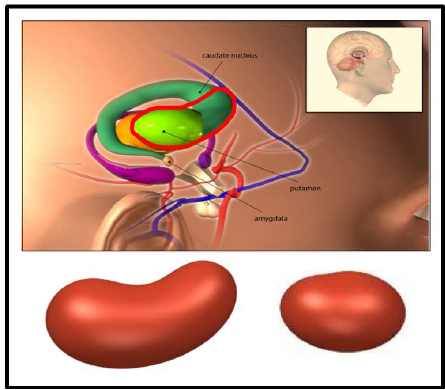
Figure 2. The boundary points, denoted by black points, and the approximated ellipses, denoted in red, of the region of uptakes in 2D-combined images for ( a ) a normal subject and ( b ) an abnormal subject.